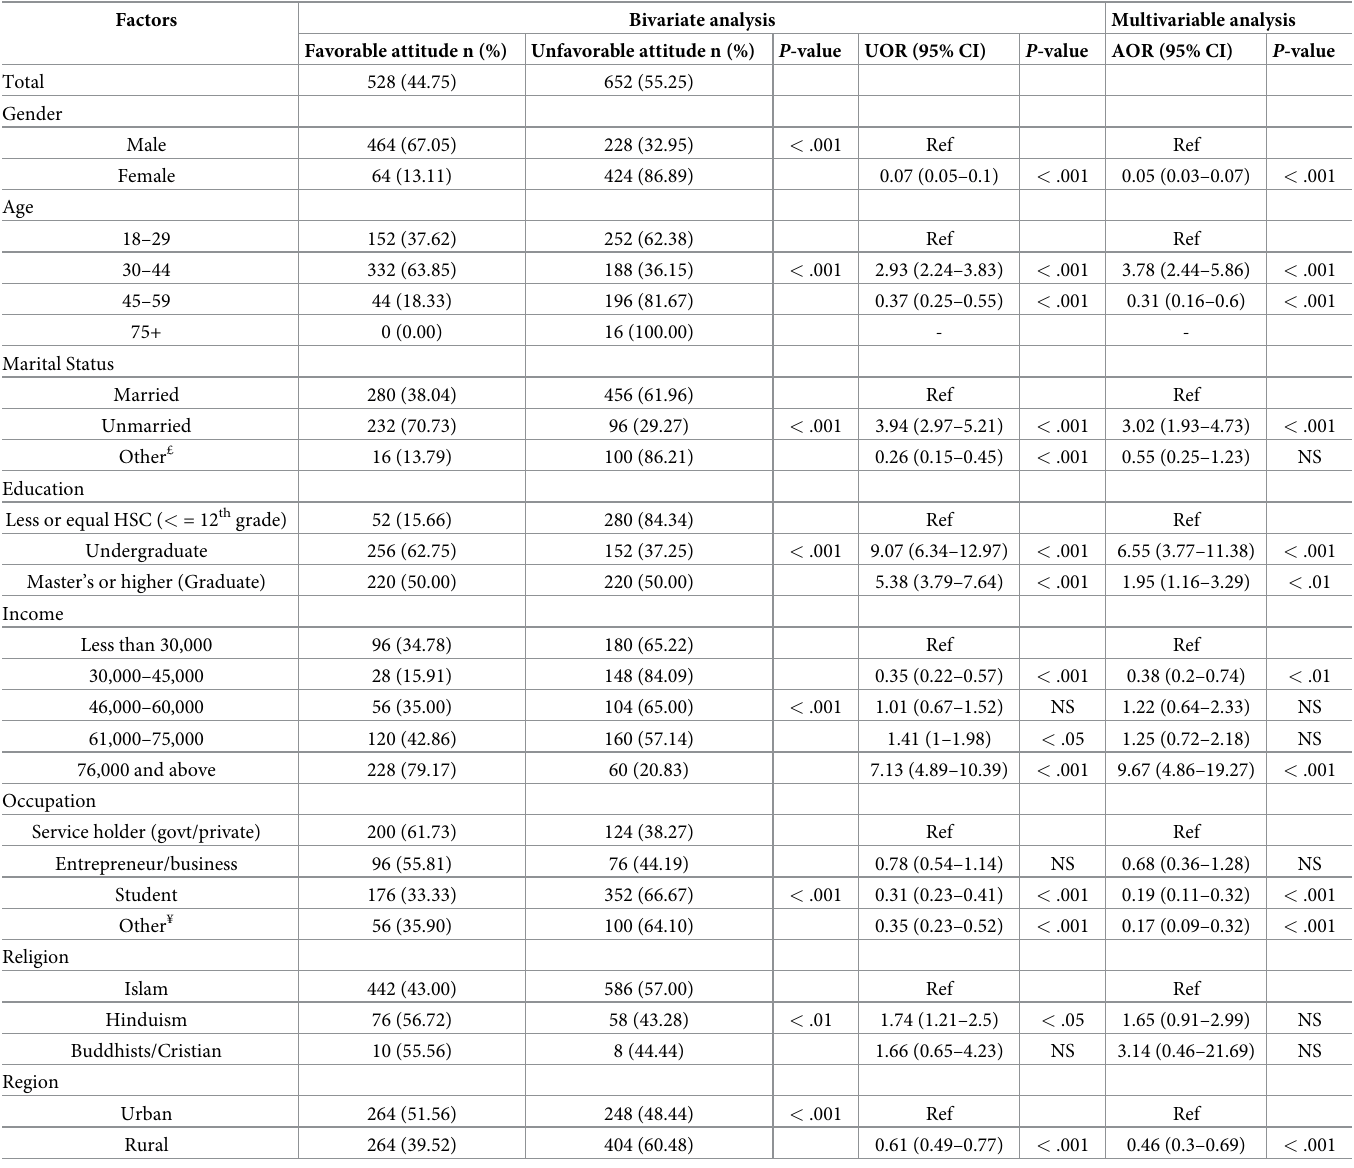
Table 5. Associated factors with attitude toward TB among the